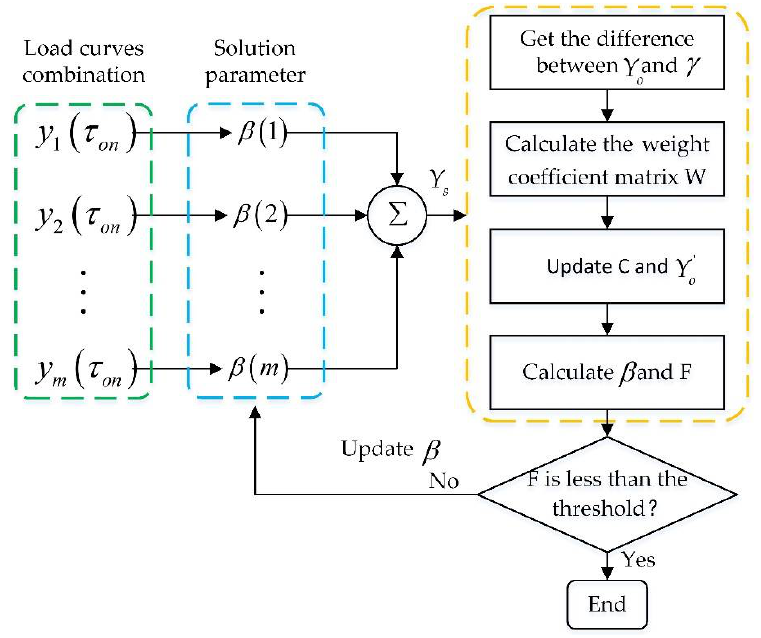
Figure 5. Objective function solving module.